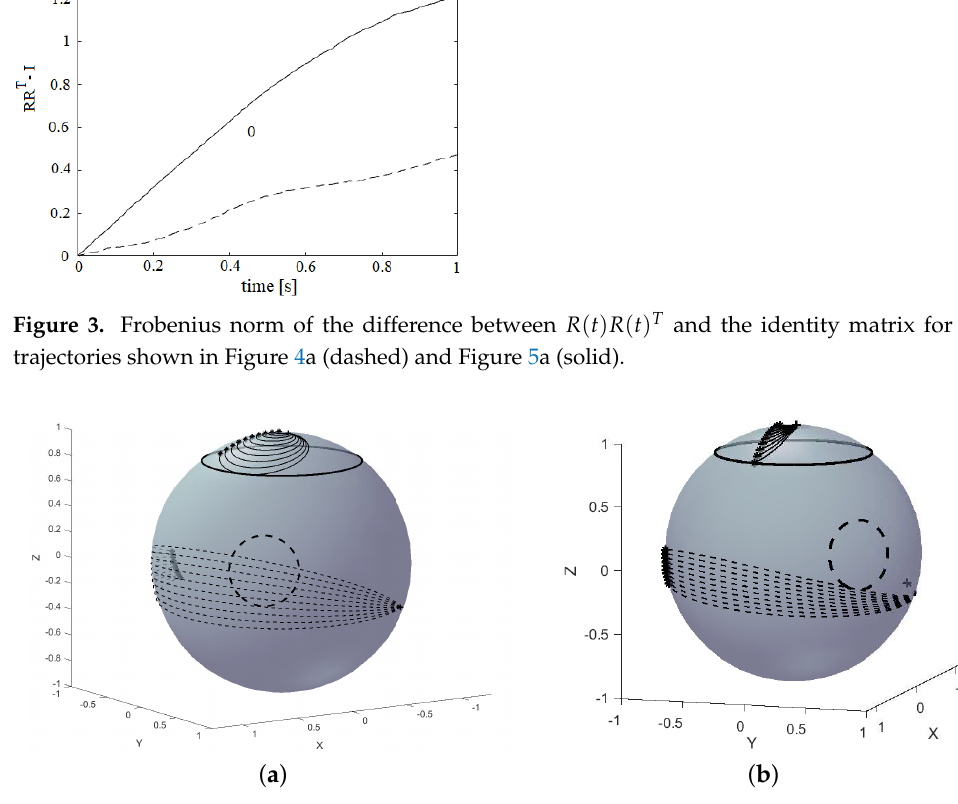
Figure 4. Correcting for a bright spot. The initial trajectories constructed between the points ( a ) in determining the pointing-constraint trajectory described by the parameters in Path 1 and the same trajectories after choosing the c i values using reinforcement learning ( b ). The initial points are indicted by + and the final points by ∗ (initial and final points from Equation